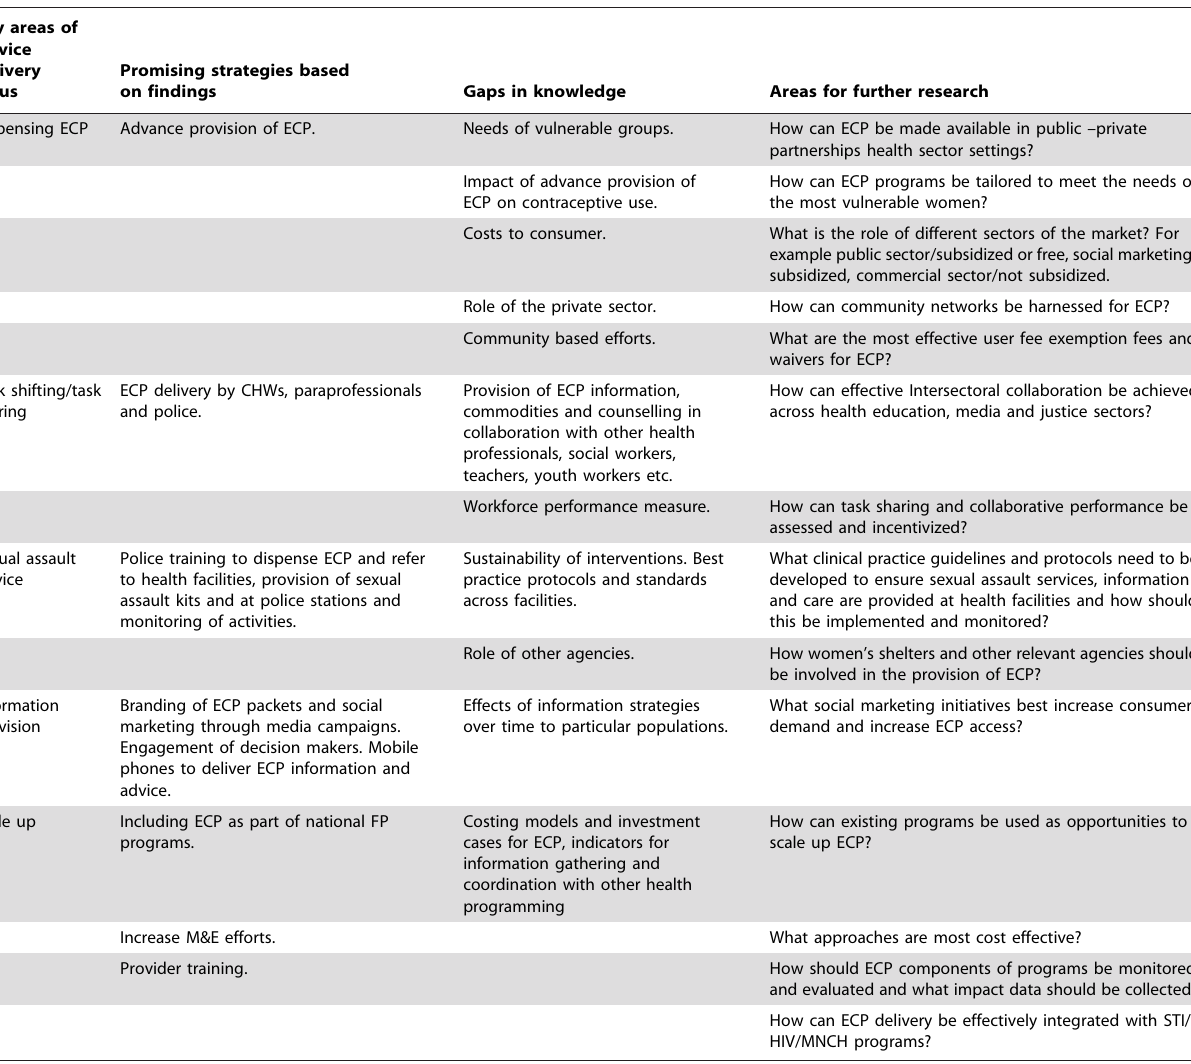
Key areas of service